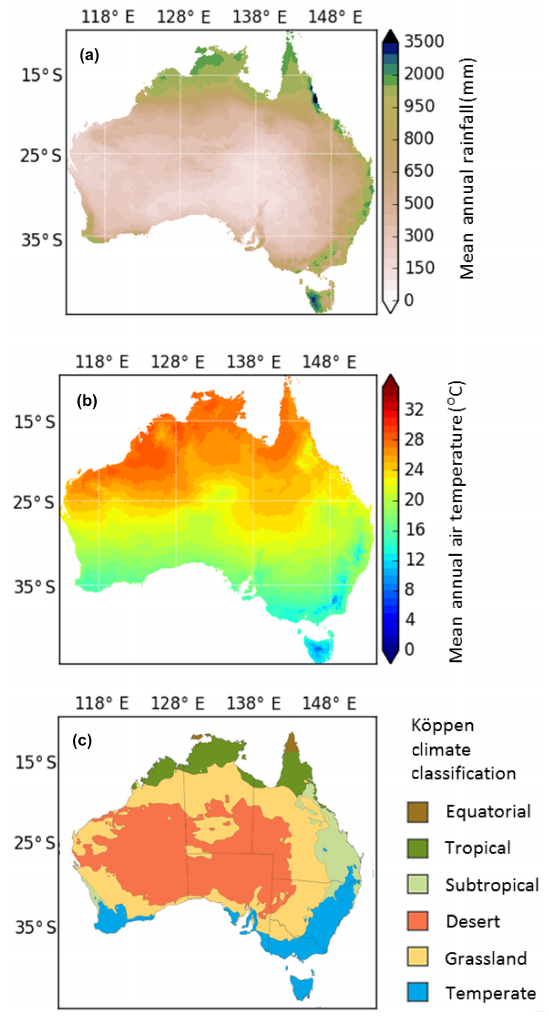
Figure 1. Mean annual rainfall (a) , mean annual air temperature (b) and the major zone Köppen–Geiger climate classification (c) for Australia from 1961 to 1990 (data source: Australian Bureau of Me- teorology,